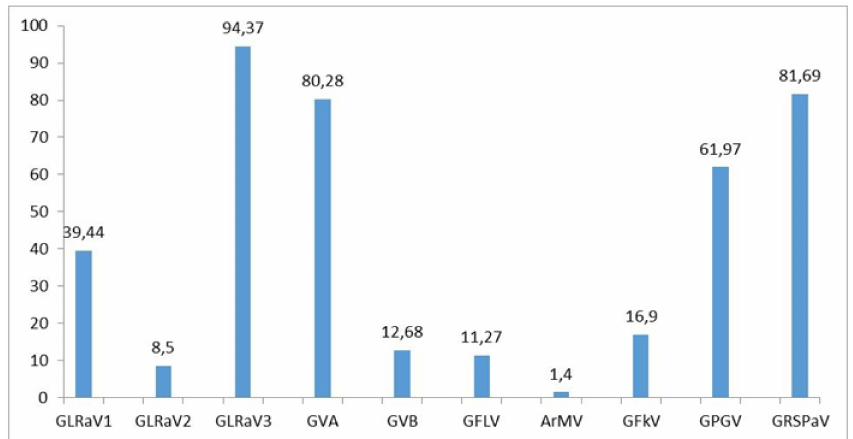
Figure 1. Prevalence of 10 analyzed viruses in 71 samples of autochthonous grapevine varieties at the Croatian Adriatic coast. Only two samples of cv Plavac mali were single infected with GLRaV-3, while all other samples had multiple infections. The most common combination (16.42%) comprised GLRaV-3, GVA, GRSPaV, and GPGV (Figure 2).